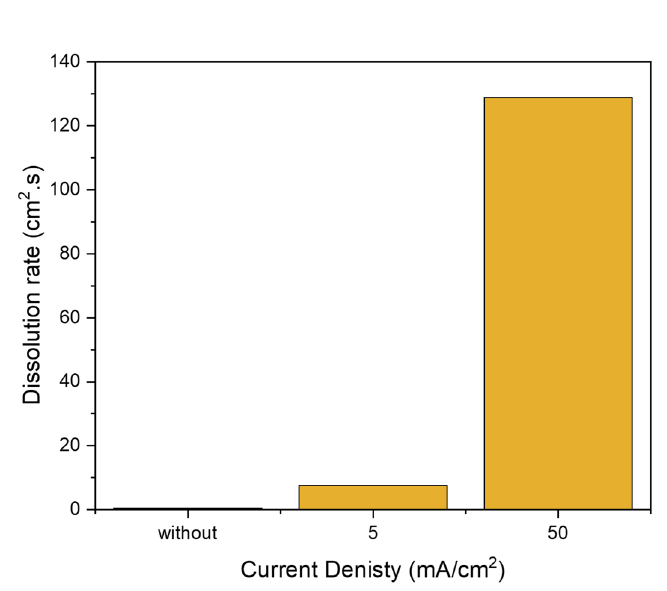
Figure 9. Effect of current density on pyrite dissolution in DTPAK 5 10 wt. % + K 2 CO 3 9 wt.